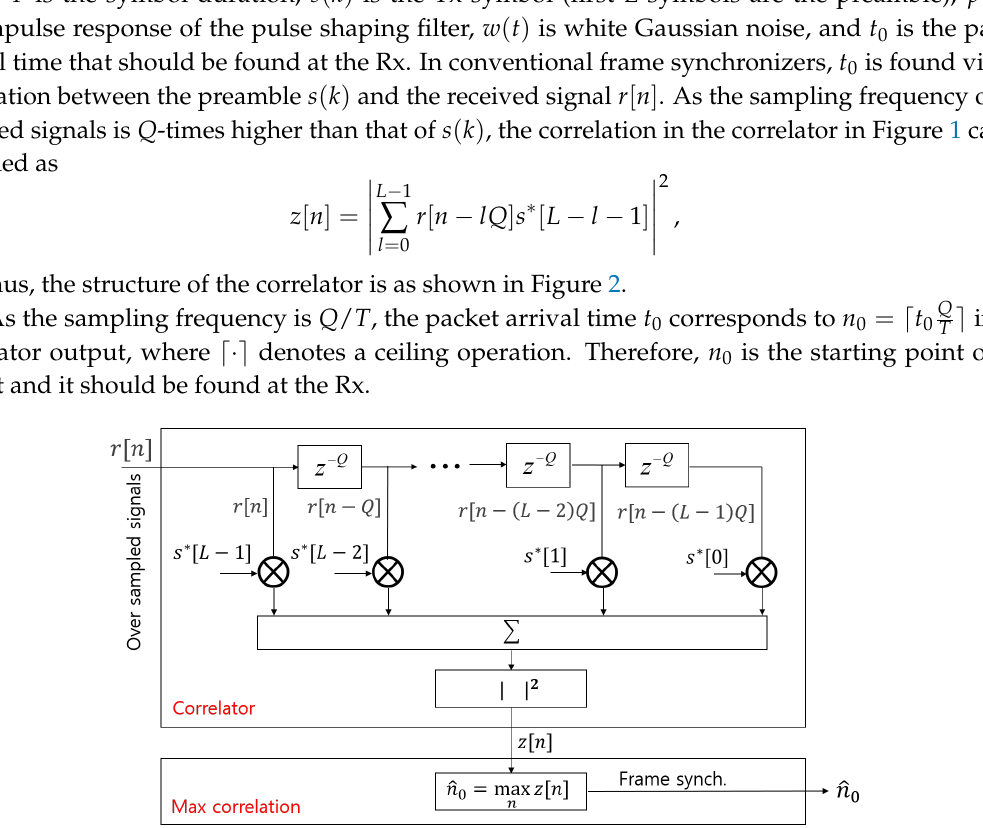
Figure 2. Structure of the correlator and frame synchronization based on the maximum correlation in Figure